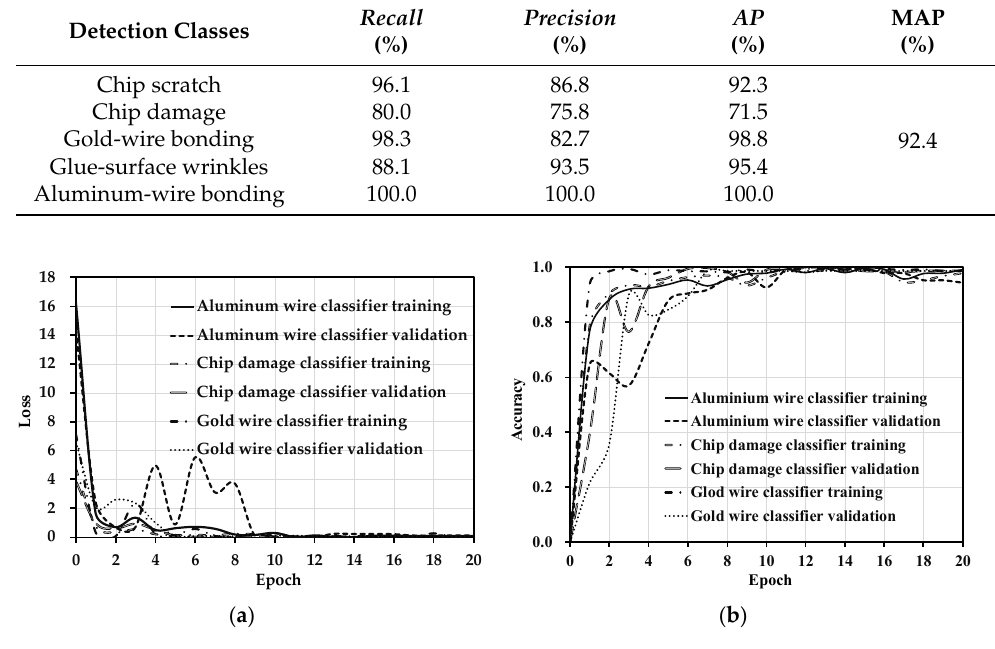
Figure 10. MEMS pressure-sensor detection-classification network. ( a ) Loss. ( b ) Accuracy.